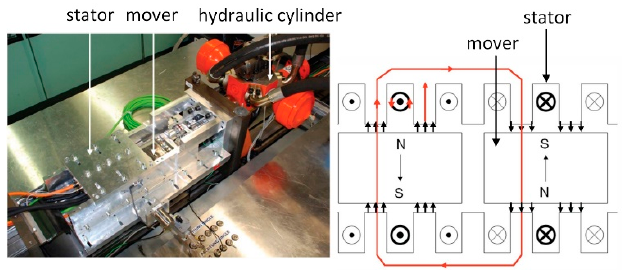
Figure 14. Second generation linear generator of DLR [22].